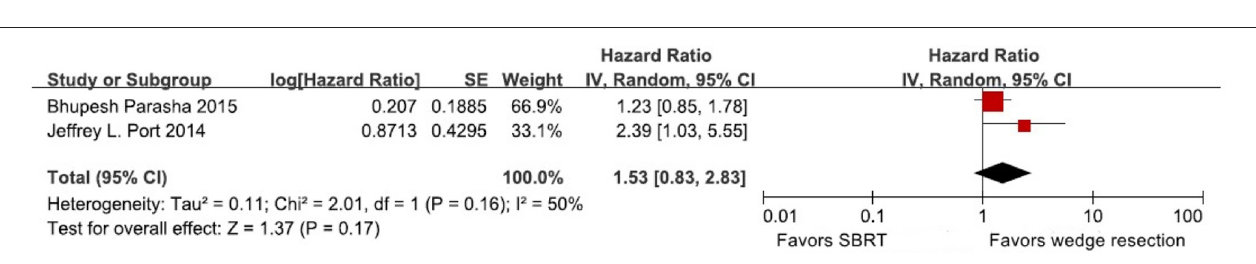
FIGURE 2 | Forest plot of 5-year OS in patients treated with wedge resection compared with SBRT; OS, overall survival; CI, confidence interval; PSM: propensity score-matched.